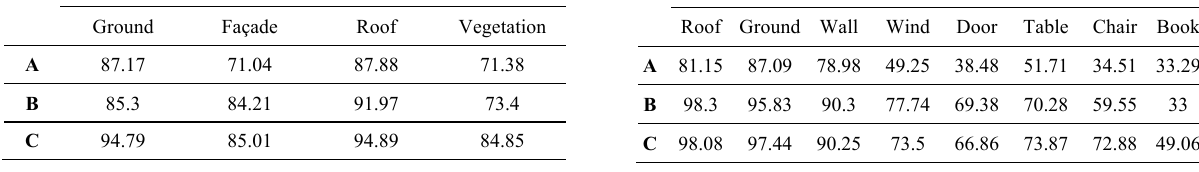
Table 5. Per-class F1 scores for the S3DIS dataset